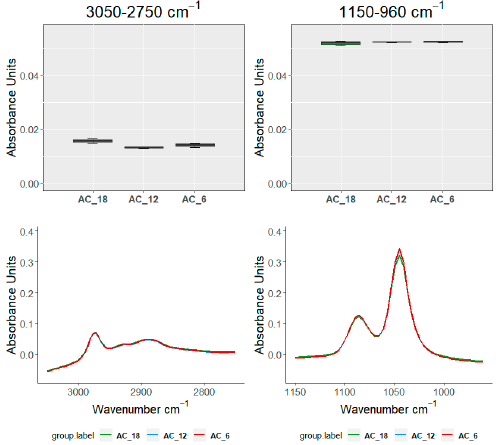
Figure 6. Plots of two of the four significant areas of the Alternative Chestnut (AC) curves. In the first row, vectorial analysis by means of boxplots. In the second row, FDA through curves in the studied interval. The wine spirit sample is divided into three groups depending on the ageing time (18, 12, 6 months of ageing).